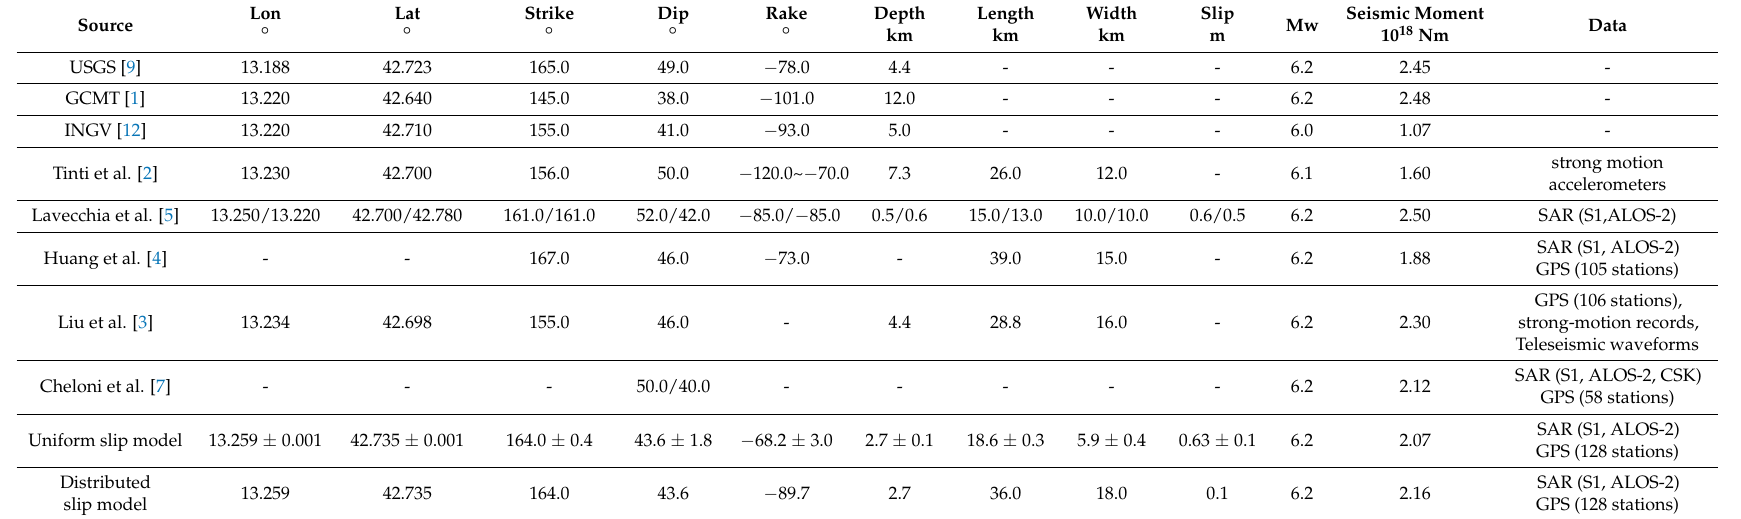
Table 3. Source parameters of the 24 August 2016